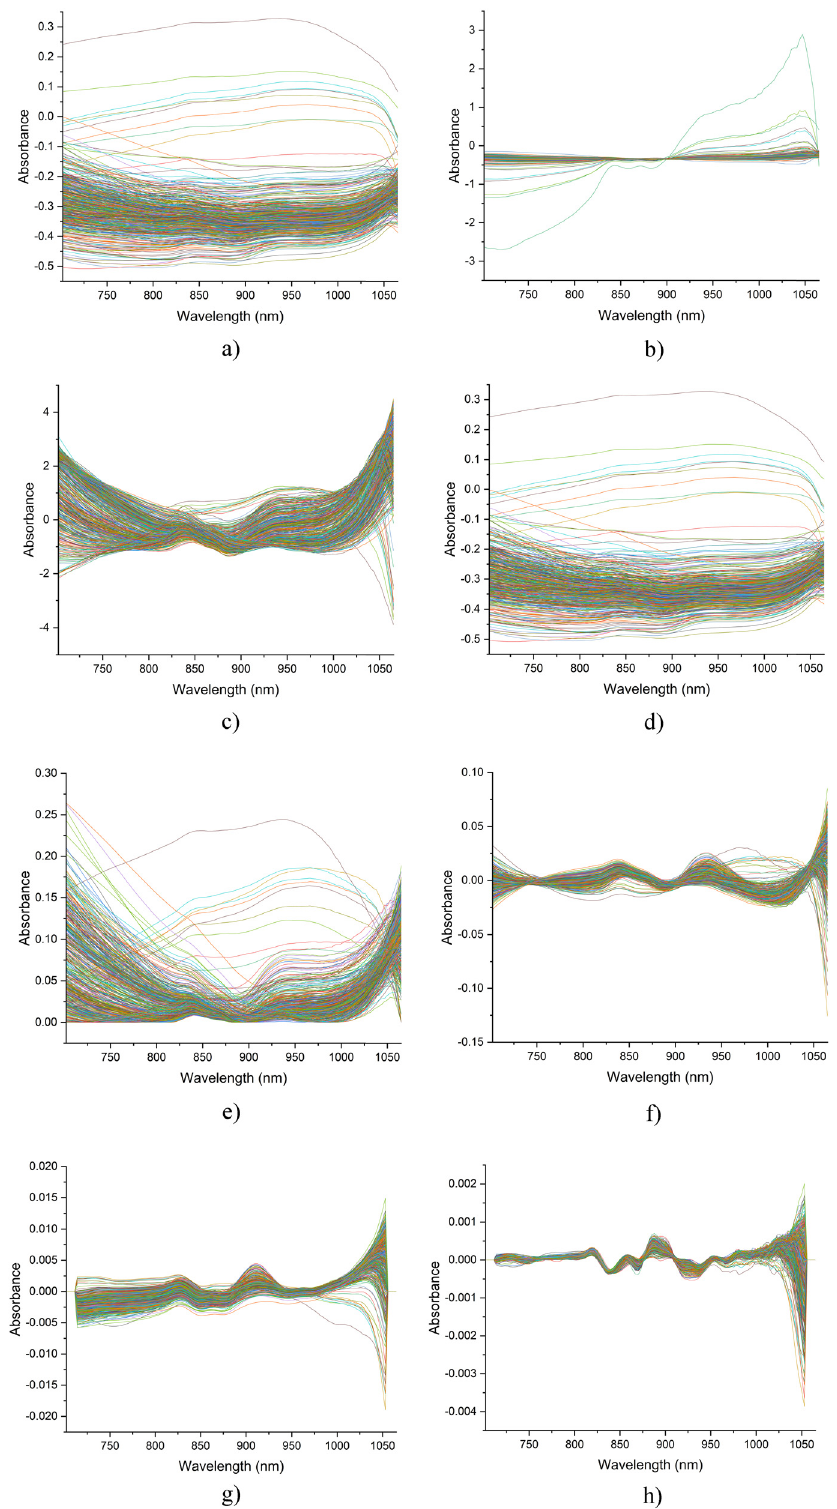
Figure 1: Original and preprocessed spectra of samples. ( a ) Original, ( b ) MSC, ( c ) SNV, ( d ) MA, ( e ) baseline, ( f ) detrending, ( g ) dg1, and ( h )